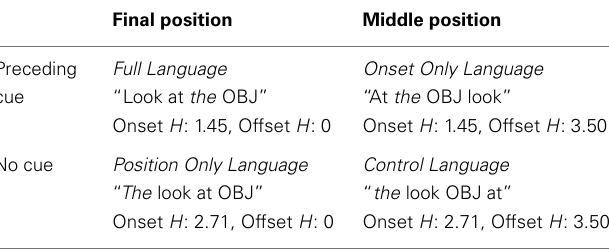
Table 2 |The 2 × 2 design of the artificial language